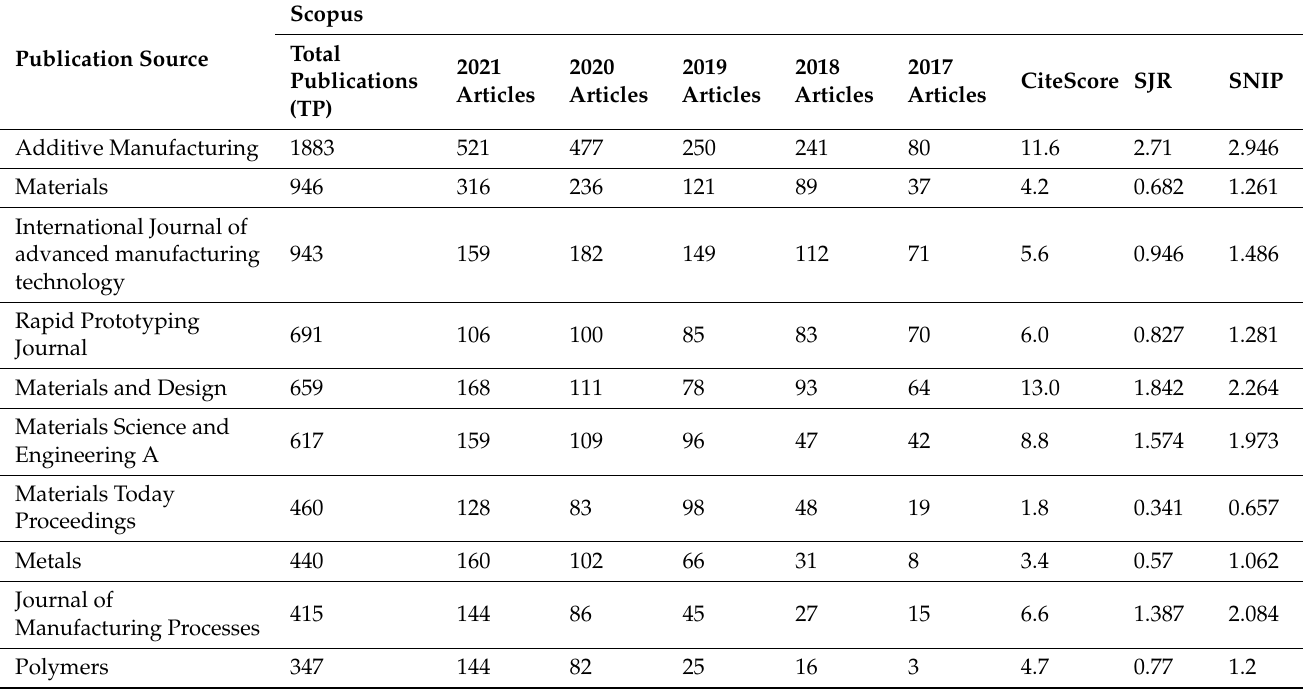
Table 1. Publications in Scopus in the top journals for additive manufacturing on lattice